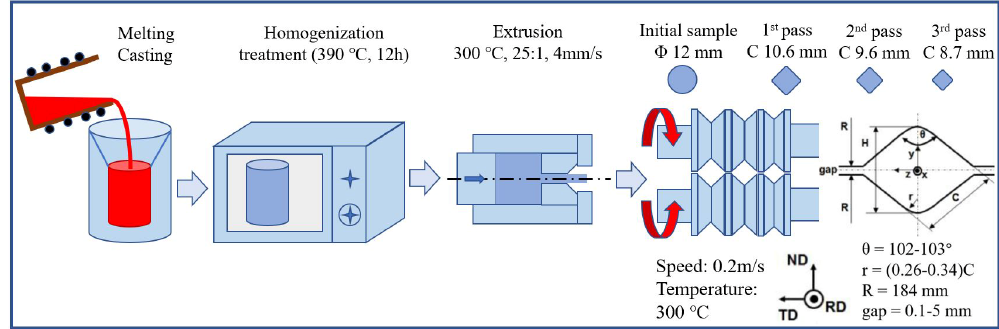
Figure 1. Schematic illustration of cast, homogenization, extrusion, and caliber rolling.